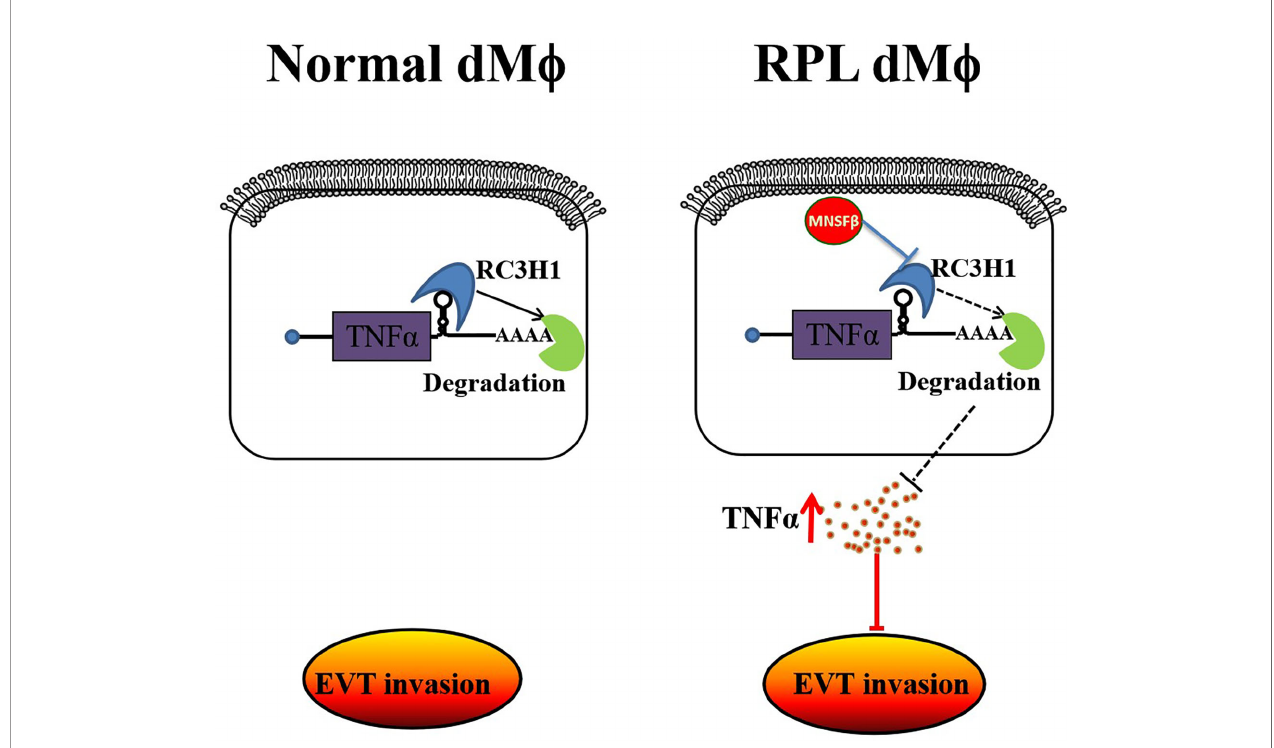
FIGURE 7 | Schematic showing that MNSF b promotes TNF a production, which inhibits the invasion of trophoblasts, by interacting with RC3H1 in RPL dM f ; dM f : decidual tissue